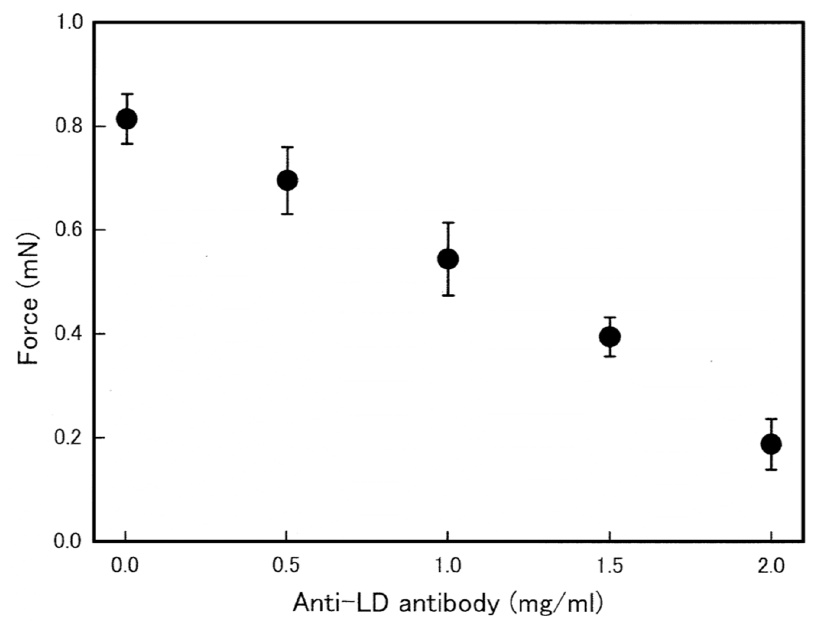
Figure 7. Inhibitory effect of anti-LD antibody on Ca 2 + -activated isometric force development. The magnitude of steady Ca 2 + -activated isometric force is plotted against the antibody concentration. Vertical bars represent S.E.M. (n=4 , 6).